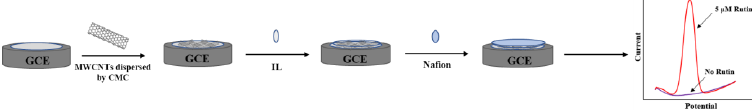
Figure 1. Fabrication procedure of the nanocomposite-modified sensor.